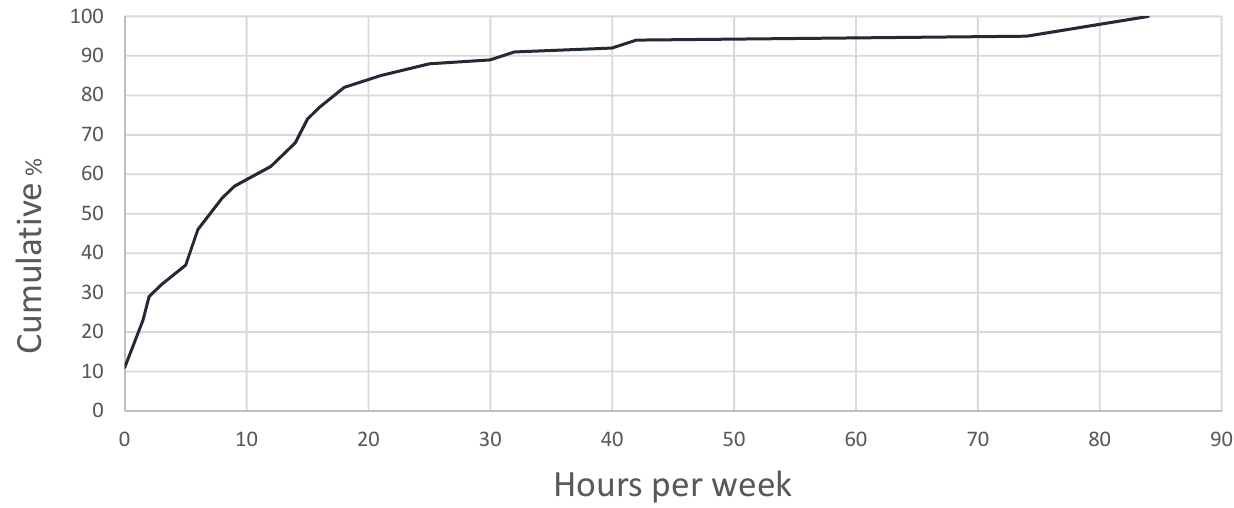
Figure 1. Cumulative frequency (%) graph of the time spent at the private residence (outside the family home) most commonly visited by young children in the last month, Broken Hill, 2018. Table 3. Relationship to the occupant of the most commonly visited private residence where a child spent time outside the family home,